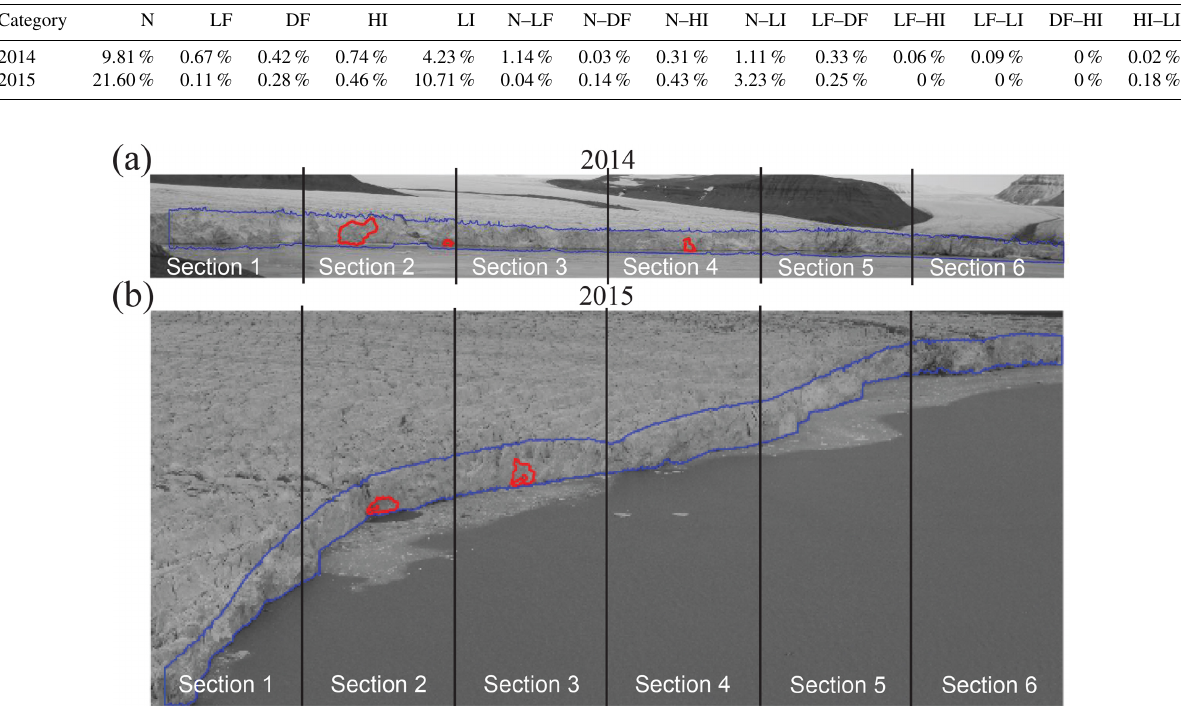
Figure 10. Example of mask delineation (blue) and calving detection (red) for (a) 2014 (4 September, 16:01) and (b) 2015 (19 August, 19:10). The front is divided into six sections shown in the figure.